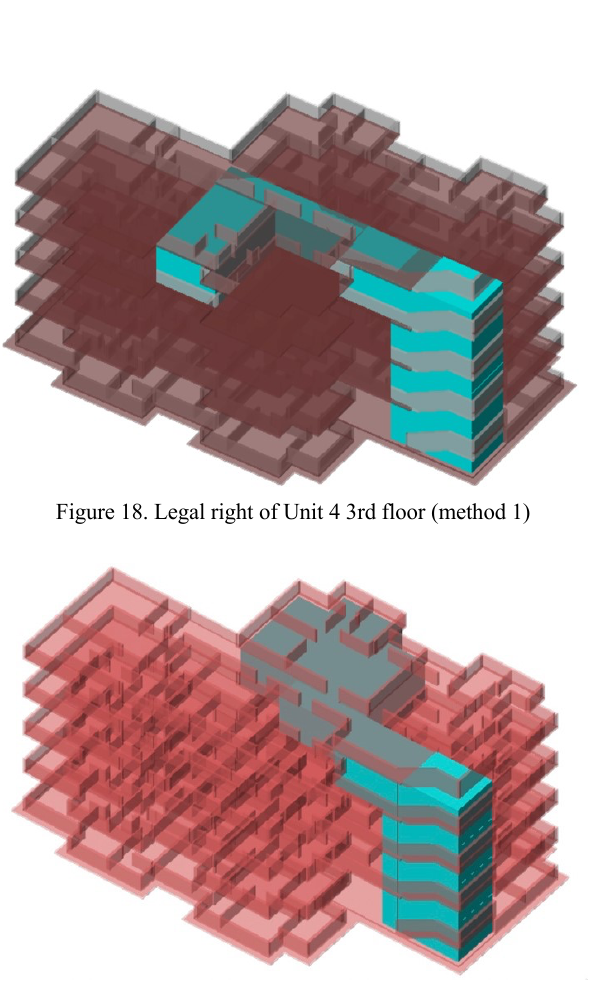
Figure 19. Legal right of Unit 1 3rd floor (method